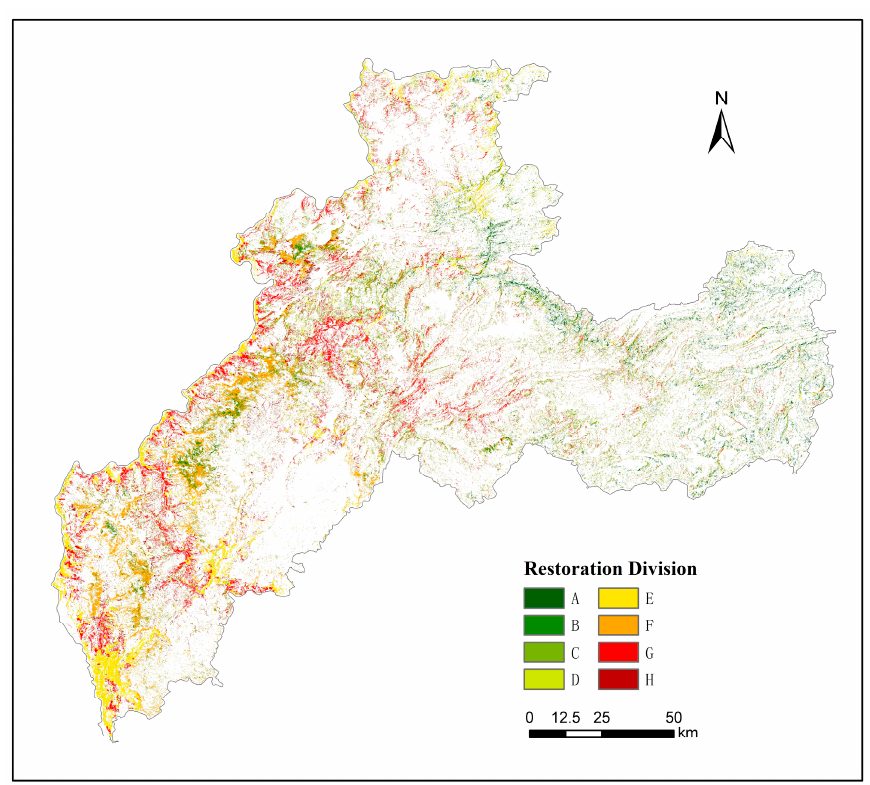
Figure 9. Division and distribution of grassland restoration pattern in Zhaotong.